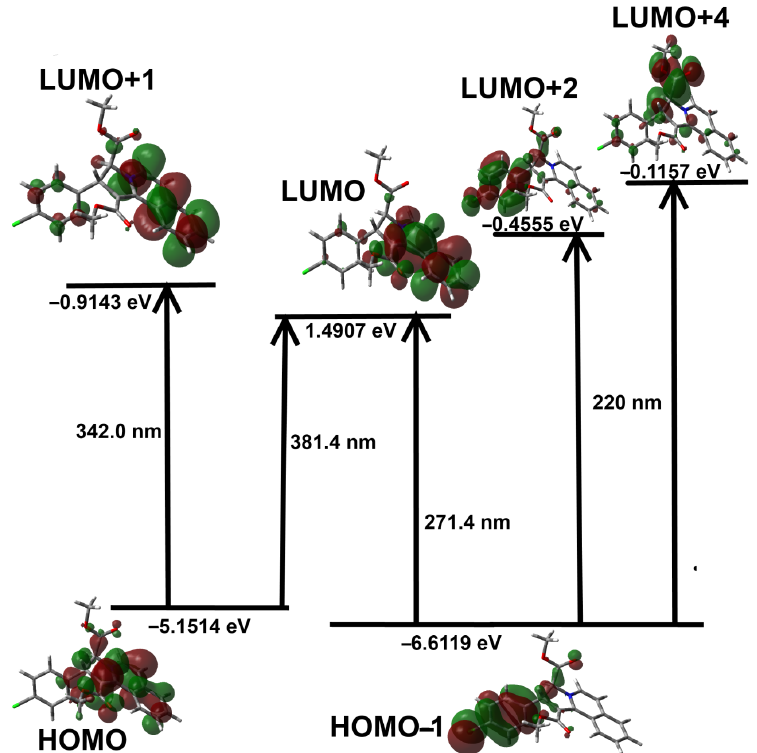
Figure 9. MOs included in the electronic absorption bands for the studied system.